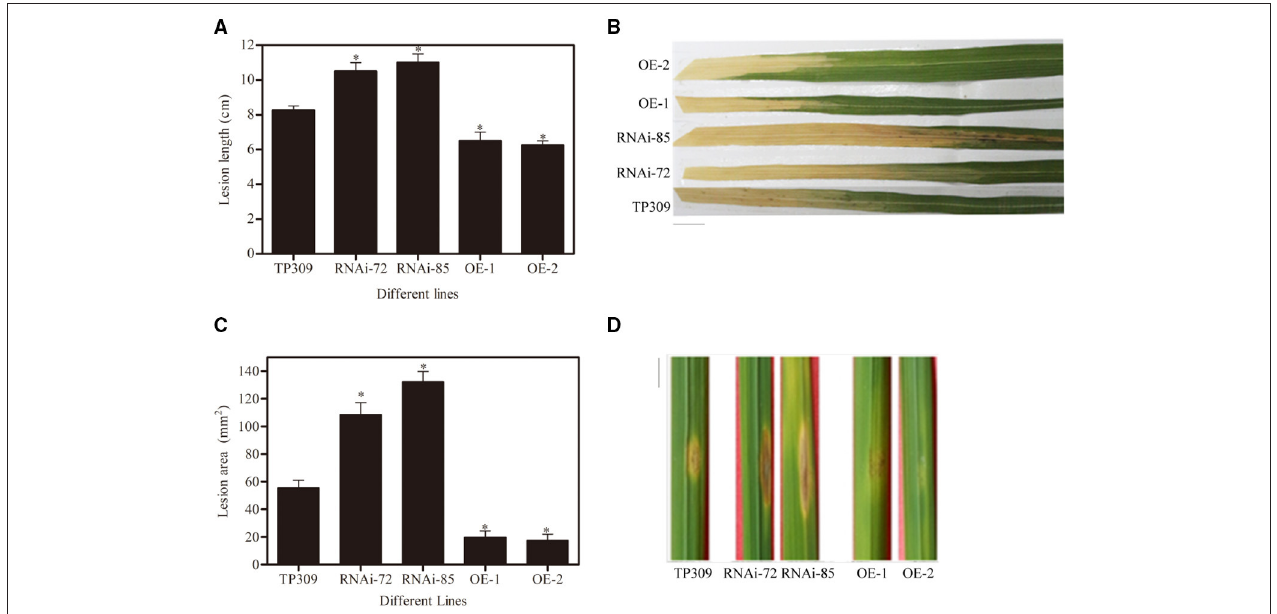
FIGURE 5 | Disease resistance identification of transgenic materials. (A) Lesion lengths in transgenic plants were measured at 14 days postinoculation with Xoo -PXO99. (B) A photograph depicting disease symptom development in leaves 14 d postinfection with Xoo -PXO99. Scale bars = 1cm. (C) Lesion areas of transgenic plants were measured using ImageJ software at 7 days postinoculation with Y34. (D) A photograph depicting disease symptom development in leaves 7 d postinfection with Y34. Scale bars = 1cm. TP309: wild-type; RNAi-72 and RNAi-85: two RNAi- OsNHO1 lines; OE1 and OE2, two OsNHO1 overexpression lines. Asterisks indicate significant differences compared to TP309 ( p < 0.05) by one-way ANOVA followed by Tukey’s HSD analysis. Error bars indicate SEs. Three independent experiments were performed with similar results.